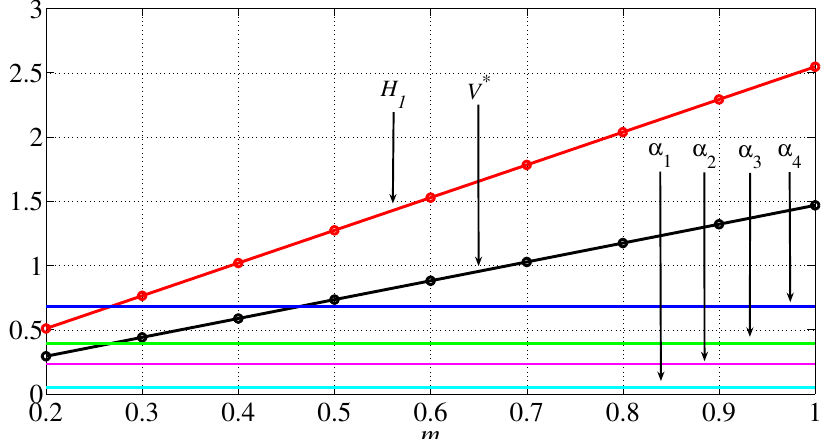
Figure 3. Switching angles, dc voltage source and fundamental harmonic behaviors as a function of m for a three-phase 9-level